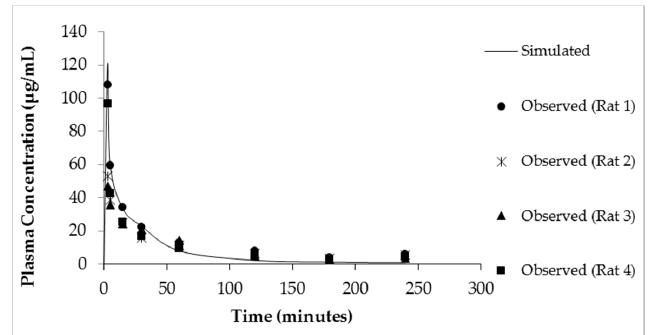
Figure 5. Simulated (solid line) and observed plasma creatine concentration–time curves after a single dose of iv CM (10 mg/kg).